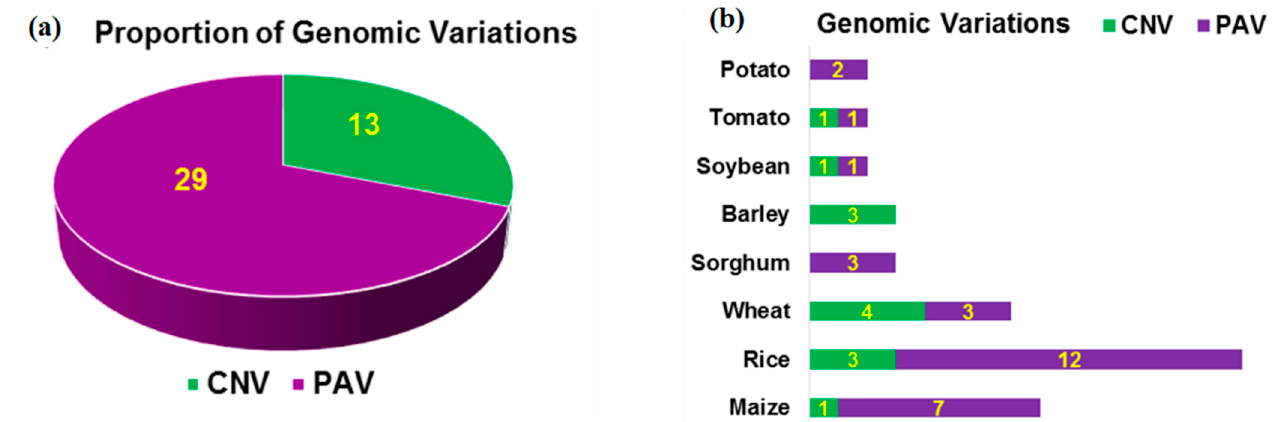
Figure 3. Genomic variation in terms of proportion ( a ) and distribution ( b ) of PAVs and CNVs in the genome of major crops for agriculturally important traits (Interpreted from Tao et al. [21].